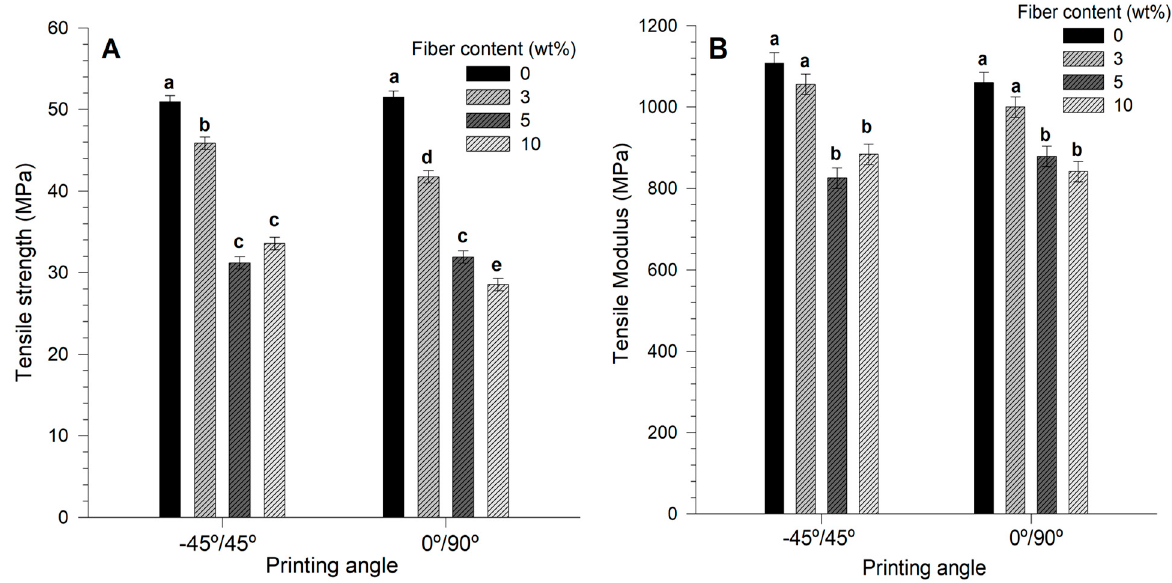
Figure 4. ( A ) Tensile strength and ( B ) tensile modulus of printed agave fibers/PLA biocomposites. The letters a–e on top of the bars indicates significant differences ( p < 0.05).